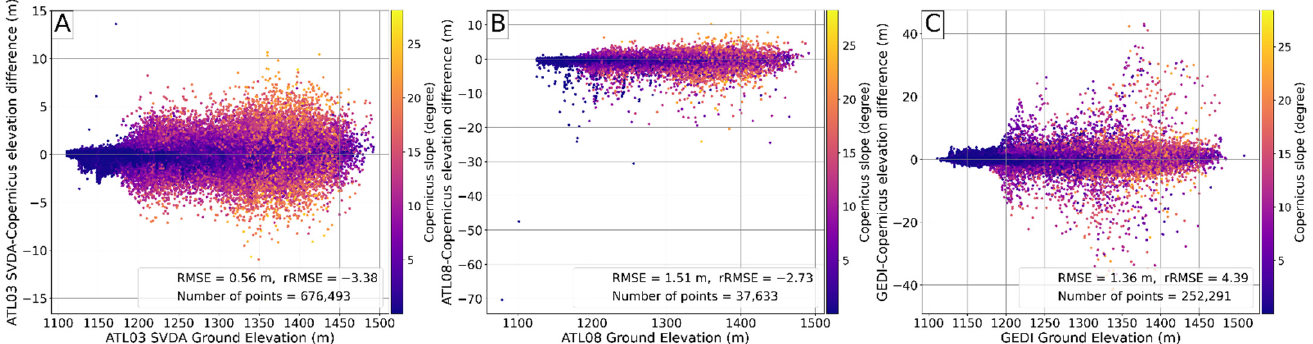
Figure 8. Copernicus DEM elevation and ATL03 SVDA based on ATL03 ground height measurements difference as described in Section 3.6.1 ( A ). ( B ): Copernicus DEM elevation and ATL08 ground height difference. We note that two ATL08 ground height points resulted in a difference more than 40 m compared to the ground elevation from Copernicus. ( C ): Copernicus DEM elevation and GEDI difference. rRMSE shows the relative RMSE (RMSE/mean of elevation difference). All elevation points are shown in this figure; see Supplementary Figure S8 for a comparison only of DEM slopes less than 5